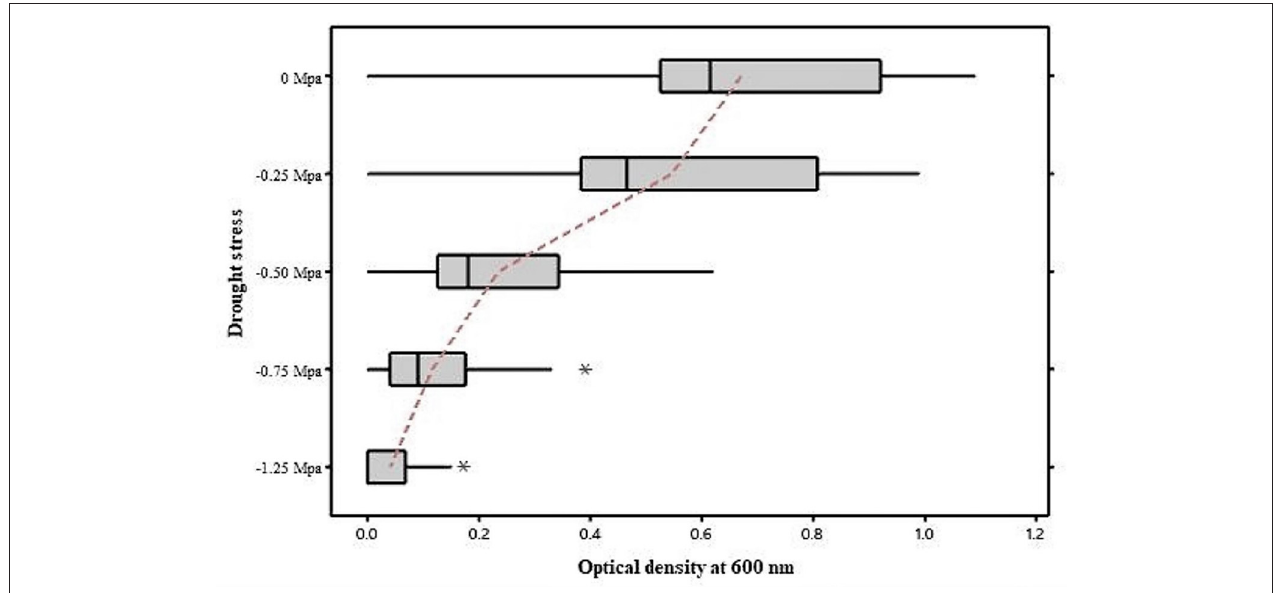
FIGURE 1 | Growth of bacterial Isolates under drought stress. As the concentration of PEG-6000 increases, many isolates’ growth was inhibited. Few isolates tolerated the higher concentrations of PEG-6000, which were labeled as Drought tolerant bacteria. *indicates that the isolate that doesn’t fall in the mean values.